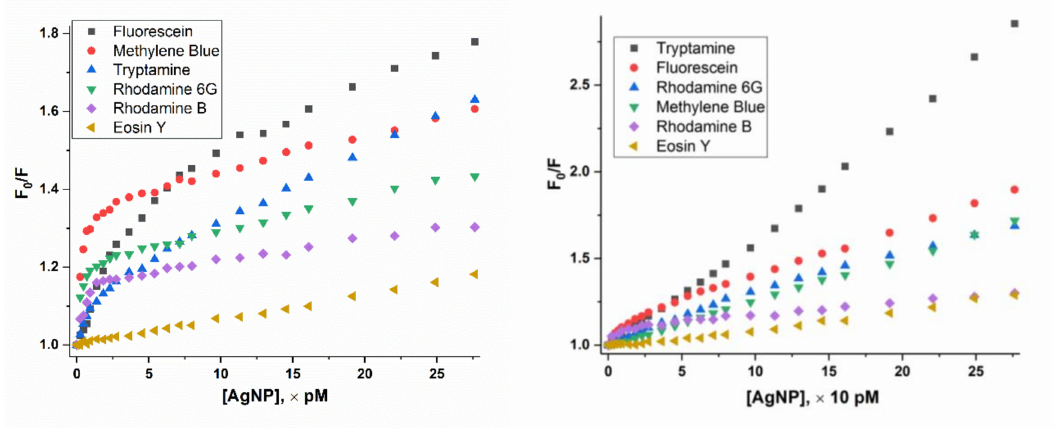
Figure 2. Plot of fluorescence intensity ratio (F 0 / F) versus AgNP concentration at dye concentration of 1 µ M (left) and 10 µ M (right). Average value from five measurements are shown and error bars are removed for a better